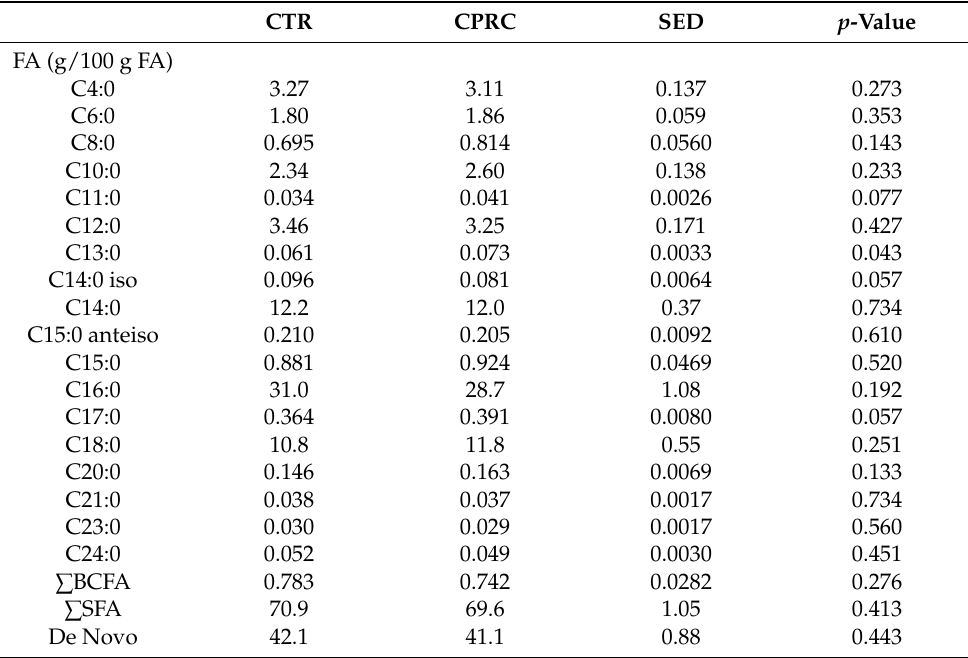
Table 7. Effect of including cold-pressed rapeseed cake in the concentrate of dairy cows on milk saturated fatty acids composition (LSM, n =